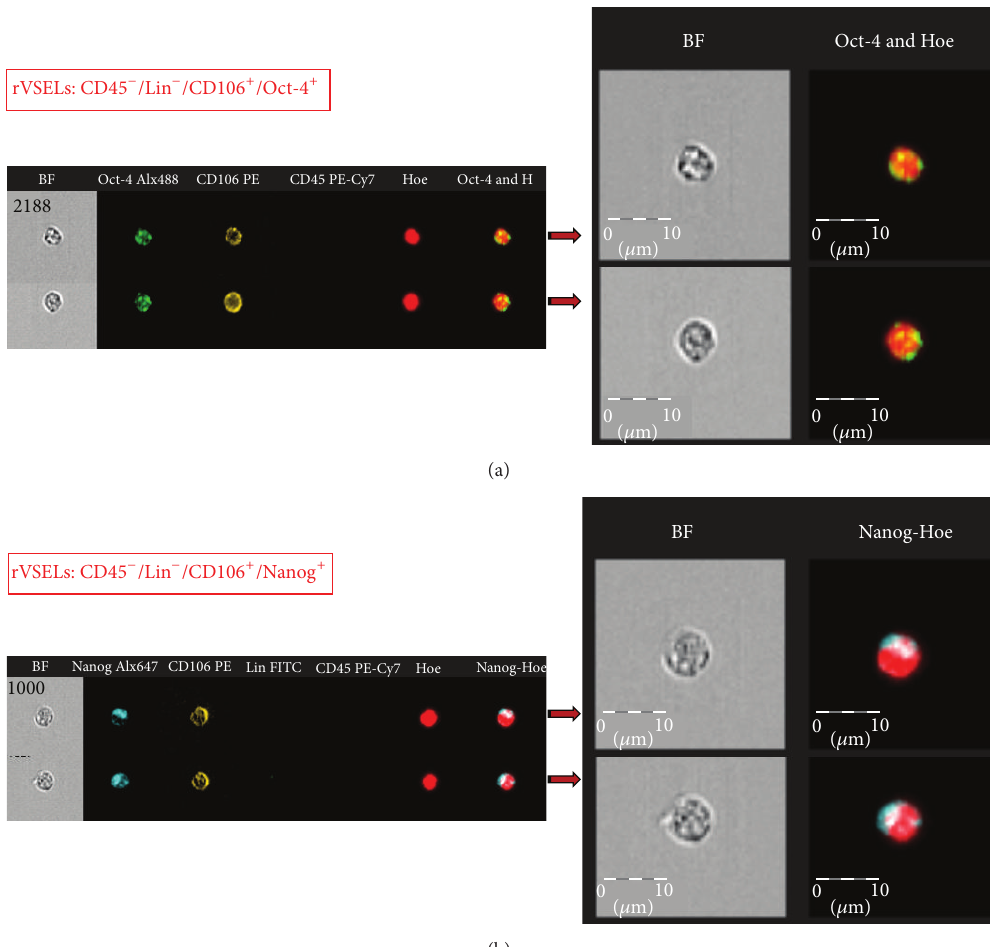
Figure 3: Expression of Oct-4A and Nanog in selected BM populations on protein level. Representative images of Oct-4A- and Nanog- expressing CD45 − /Lin − /CD106 + cells by ImageStream X system. TNCs were stained for (1) Oct-4A (Alexa Fluor 488, green), CD45 (PE-Cy7, magenta), and CD106 (PE, orange) (a) and (2) Nanog (Alexa Fluor 647, blue), Lin markers (FITC, green), CD45 (PE-Cy7, magenta), and CD106 (PE, orange) (b). Cell were stained with Hoechst 33342 to visualize nuclei and analyzed by ISS to detect intranuclear expression of Oct-4A (a) and Nanog (b) as shown in magnified, combined images. The scale bars indicate 10 𝜇